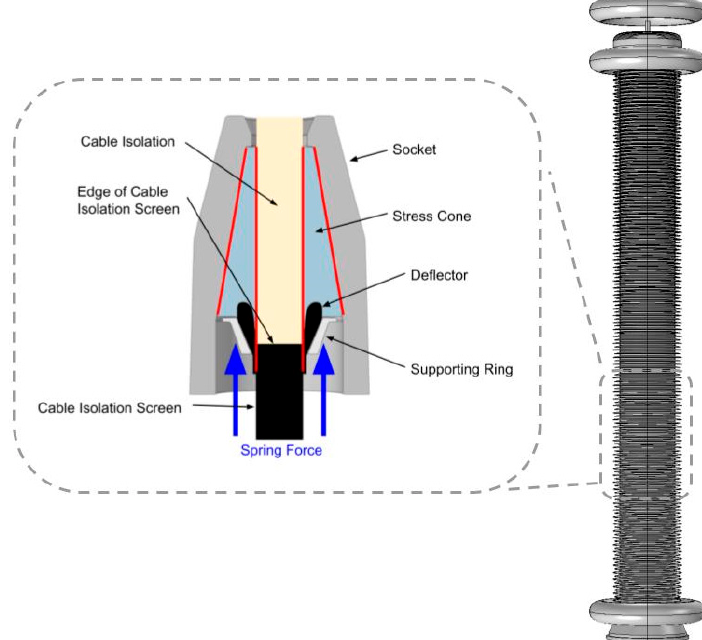
Figure 4. The composite prefabricated termination was chosen for the case study. The